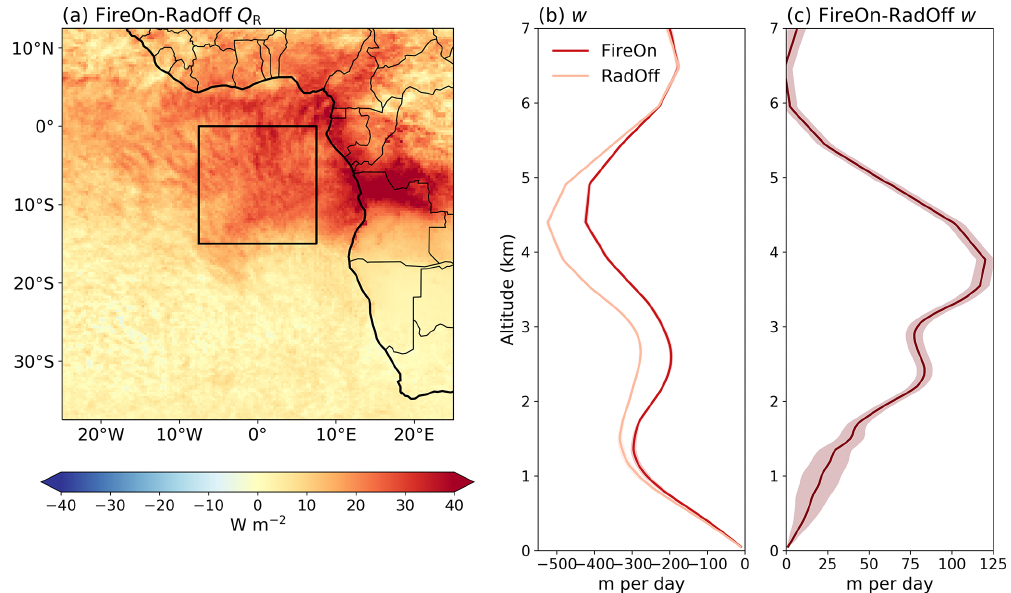
Figure 10. Atmospheric column radiative heating and vertical profile of subsidence differences between FireOn and RadOff. Subsidence values averaged over the region from 0 to 15 ◦ S, 7.5 ◦ W to 7.5 ◦ E and over the full 14–20 August 2017 period, demarcated in black in panel (a) , are shown separately for FireOn and RadOff in panel (b) and as the FireOn–RadOff difference in panel (c) . Shading in panels (b) and (c) represents 2 standard errors of the mean.